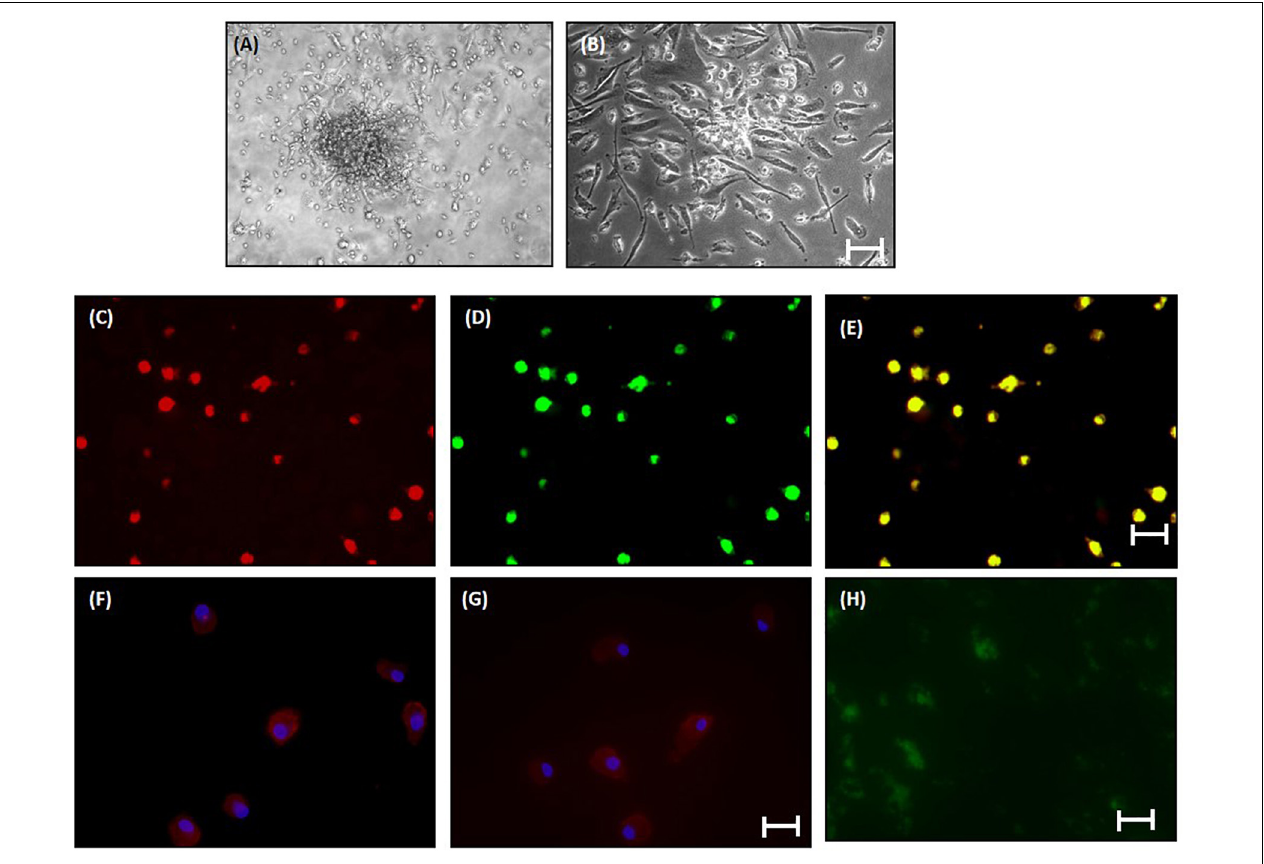
FIGURE 3 | Characterization of human EPCs from healthy controls (20x) (A) and (B) phase-contrast micrograph of culture-enriched endothelial progenitor cells (EPC-CFUs) on 7th day and 9th day in controls. (C) DiI-acLDL uptake by EPCs. (D) FITC-UEA lectin binding by EPCs (explained in the section “Materials and Methods”). (E) Overlay of (C) and (D) . (F) Immunofluorescence characterization of cultured EPCs with anti-human VEGFR2. (G) Anti-human CD34. Cells were counterstained with Hoechst dye. (H) In vivo localization of CFSE-labeled control EPCs in liver tissue sections after 24 h of